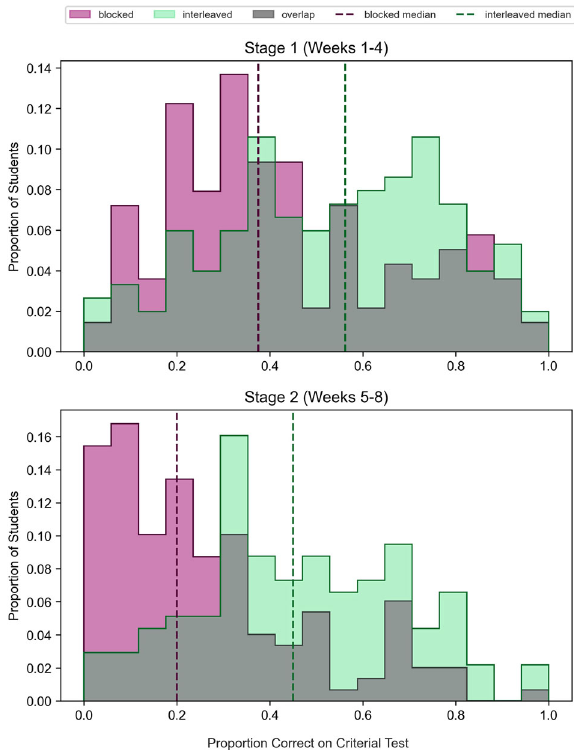
Fig. 2 Effect of interleaving versus blocking on criterial test performance. Each histogram displays the distributions of criterial test scores in a given stage, with green representing performance in the interleaved condition and purple representing performance in the blocked condition. The median score in each condition is included as a vertical bar of the corresponding color. Histograms are normalized so that in each condition, the sums of values of all bins equals 1. Mean performance in Stages 1 and 2, respectively, was 0.43 and 0.27 in the blocked condition and 0.54 and 0.47 in the interleaved